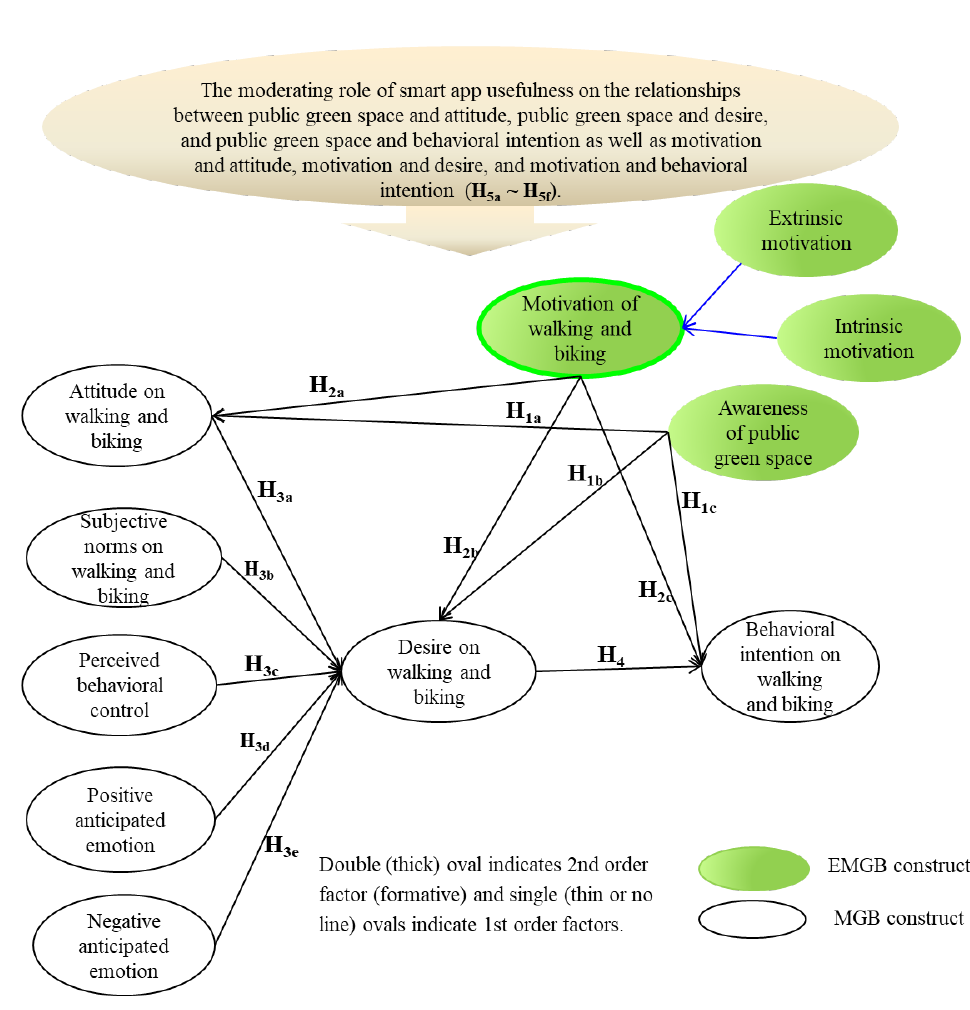
Figure 1. Proposed research model.